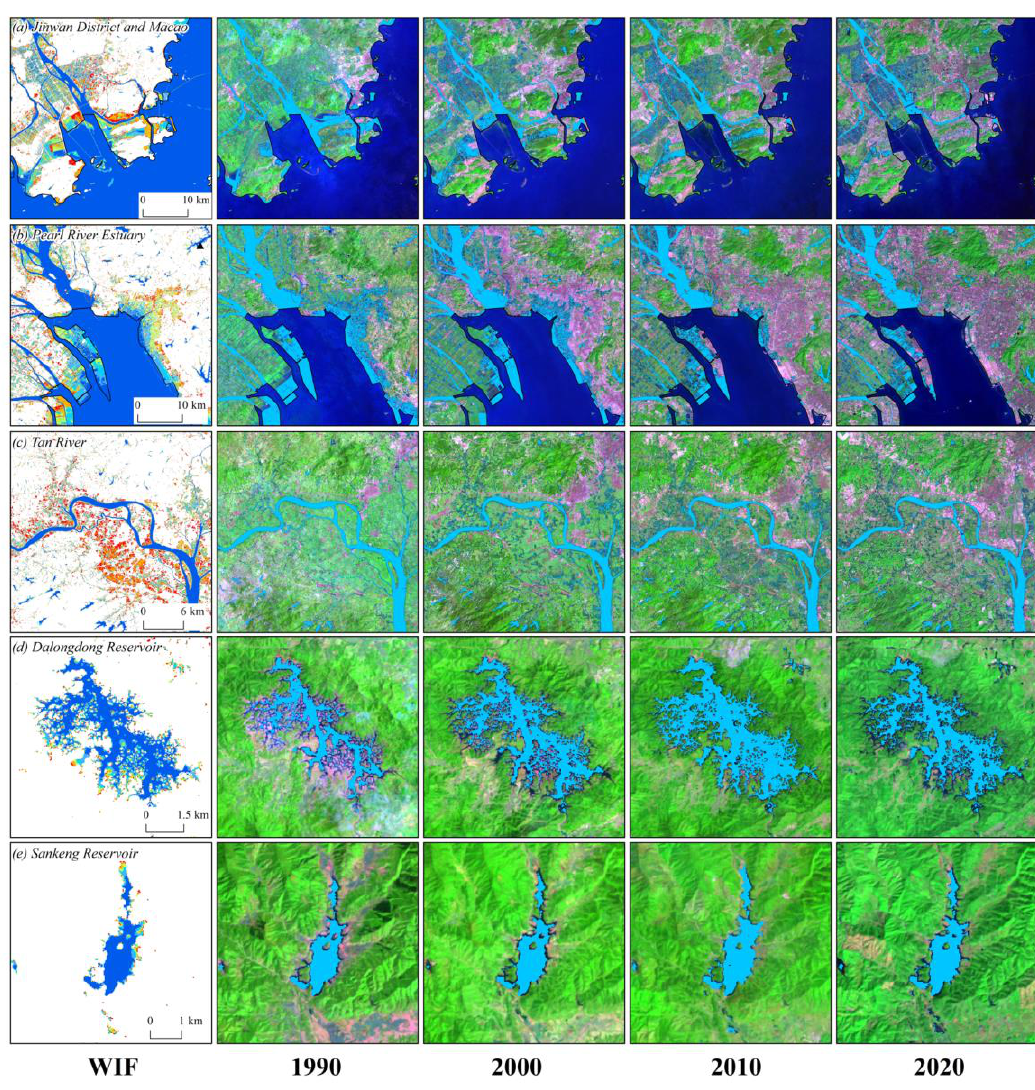
Figure 6. Surface water area changes from 1990~2020. The first column represents the water inundation frequency (WIF) from 1986 to 2020 for these five subregions. The other four columns represent the composited maximum surface water extent of these areas in 1990, 2000, 2010 and 2020. ( a – e ) represent parts of Jinwan District and Macao, Pearl River estuary, Tan River, Dalongdong Reservoir and Sankeng Reservoir, respectively.